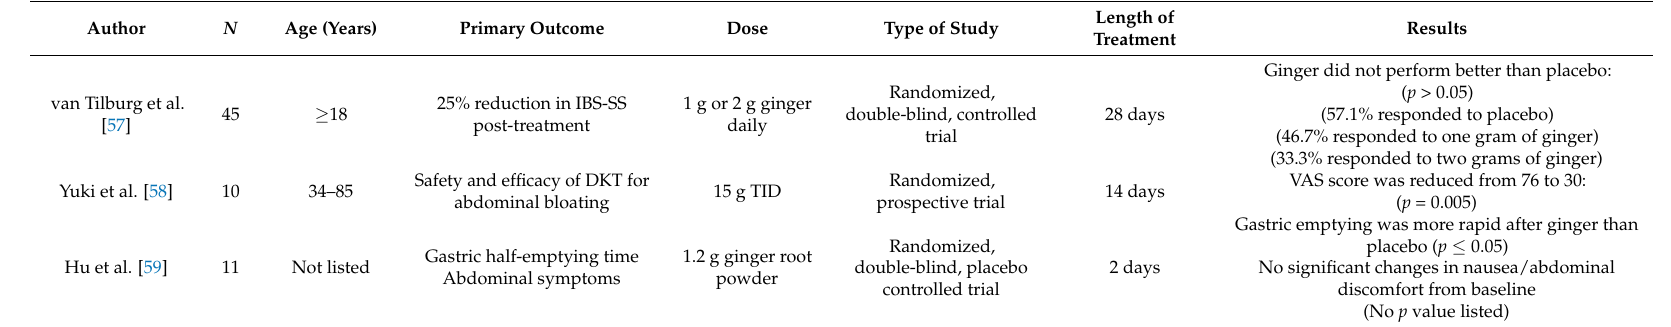
Table 6. Clinical Trials on ginger in the treatment of functional gastrointestinal